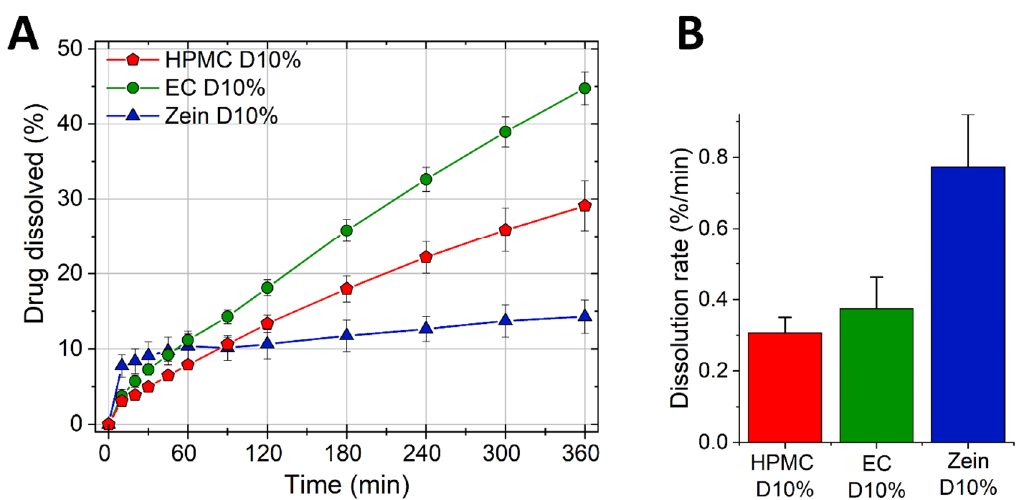
Figure 2. Dissolution profiles of HPMC, EC, and zein tablets containing 10% propranolol HCl. ( A ) Percentage of drug release (mean ± SD, n = 3) as a function of time. ( B ) Drug burst (mean ± SD, n = 3) measured as the dissolution rate in the first 10 min of the test.